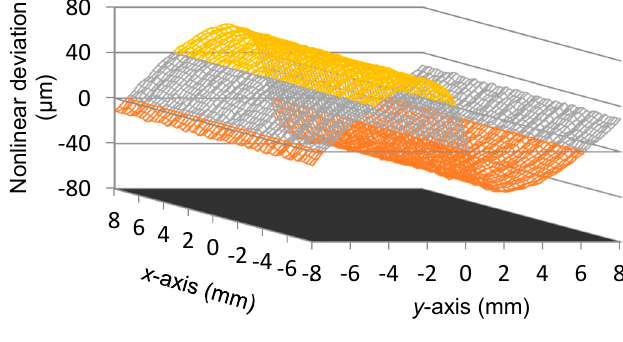
Figure 10. Nonlinear deviations of U y .